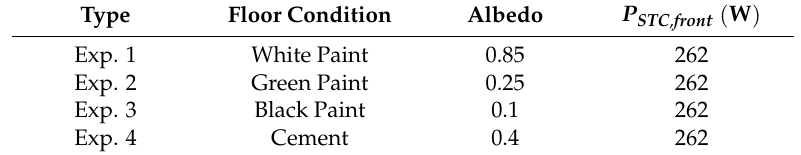
Figure 5. Bifacial Module used in the Experiments 1–4. Table 1. In-situ and module powers in the experiments.